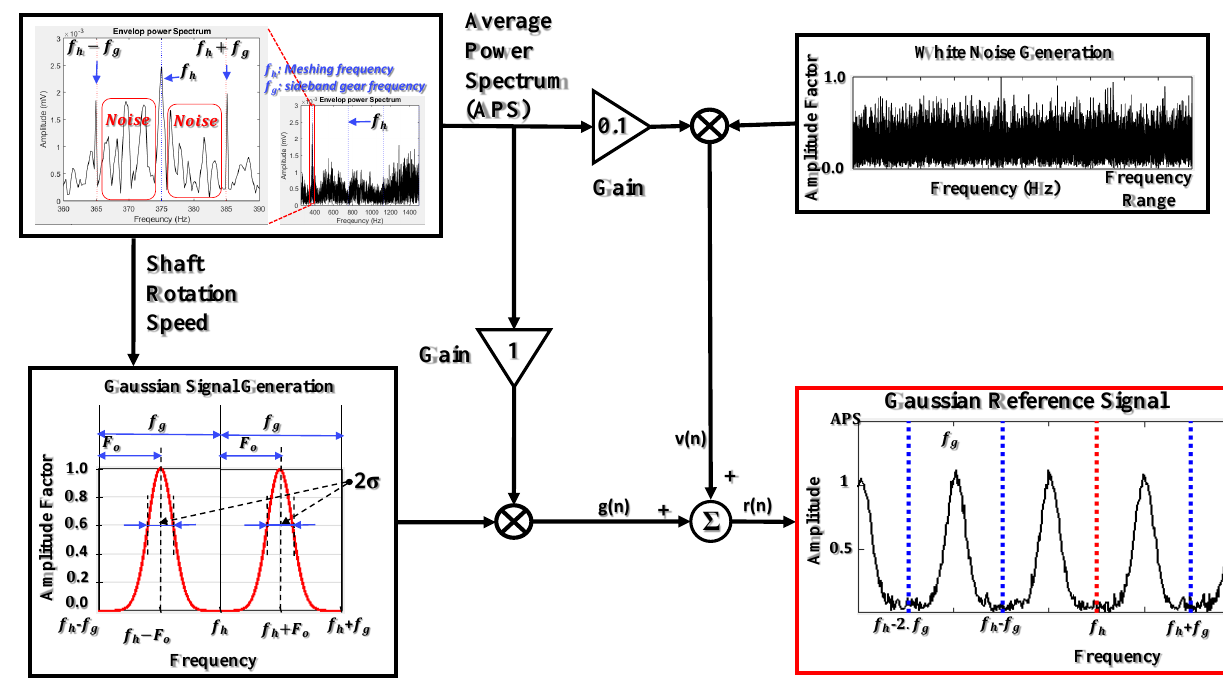
Figure 5. A functional block scheme of generating the adjustable Gaussian reference